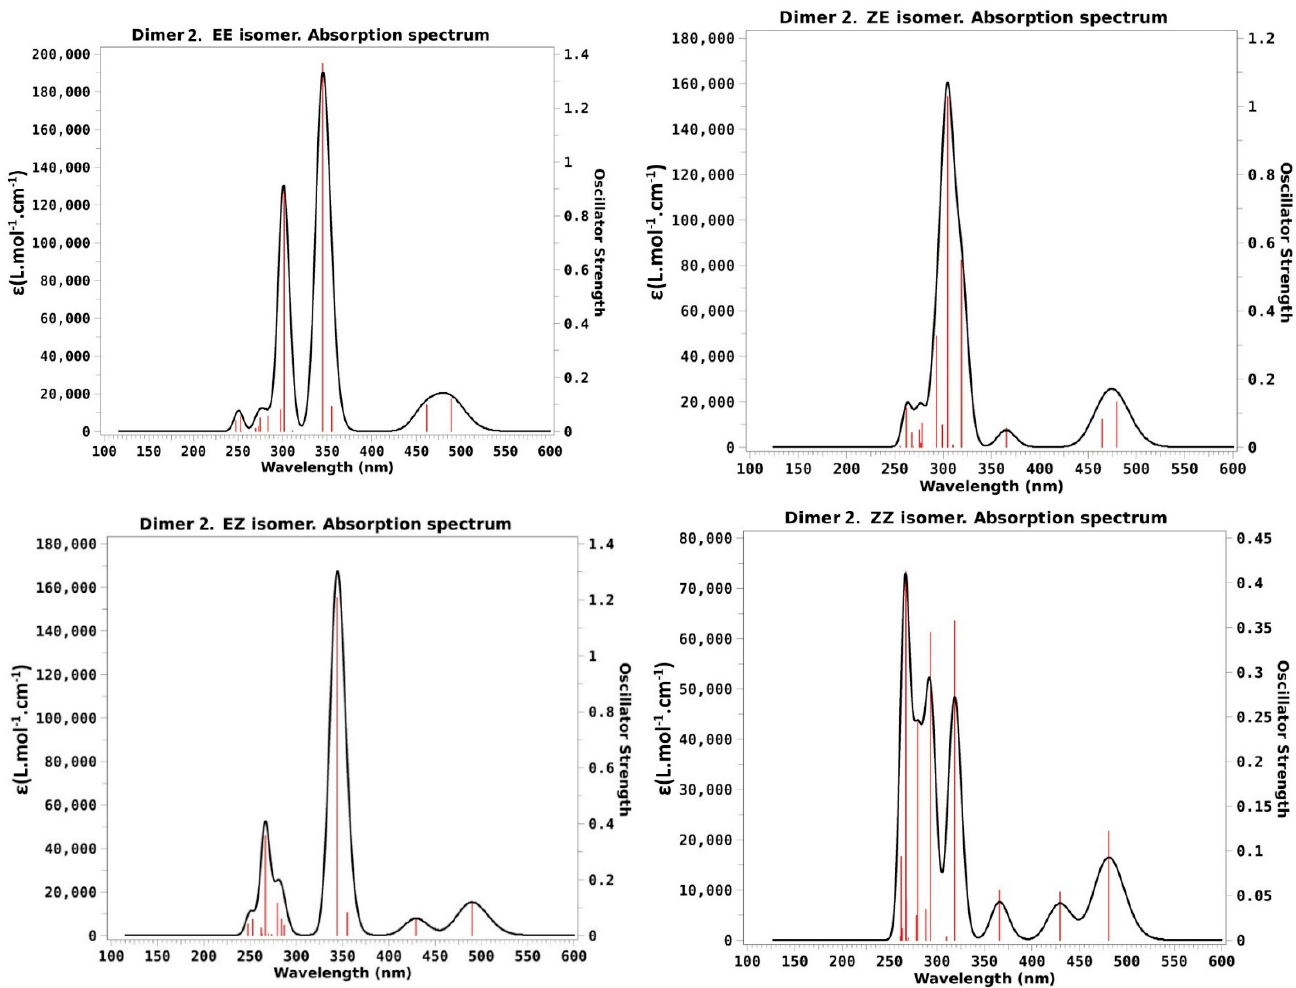
Figure 5. Computed absorption spectra of dimer 2 in acetonitrile at the optimized ground-state geometries of the four stable isomers of dimer 2. Vertical red lines indicate the position of the vertical transitions while the black contour corresponds to the convolution with a Lorentzian function depicted in order to theoretically reproduce the experimental absorption spectrum.